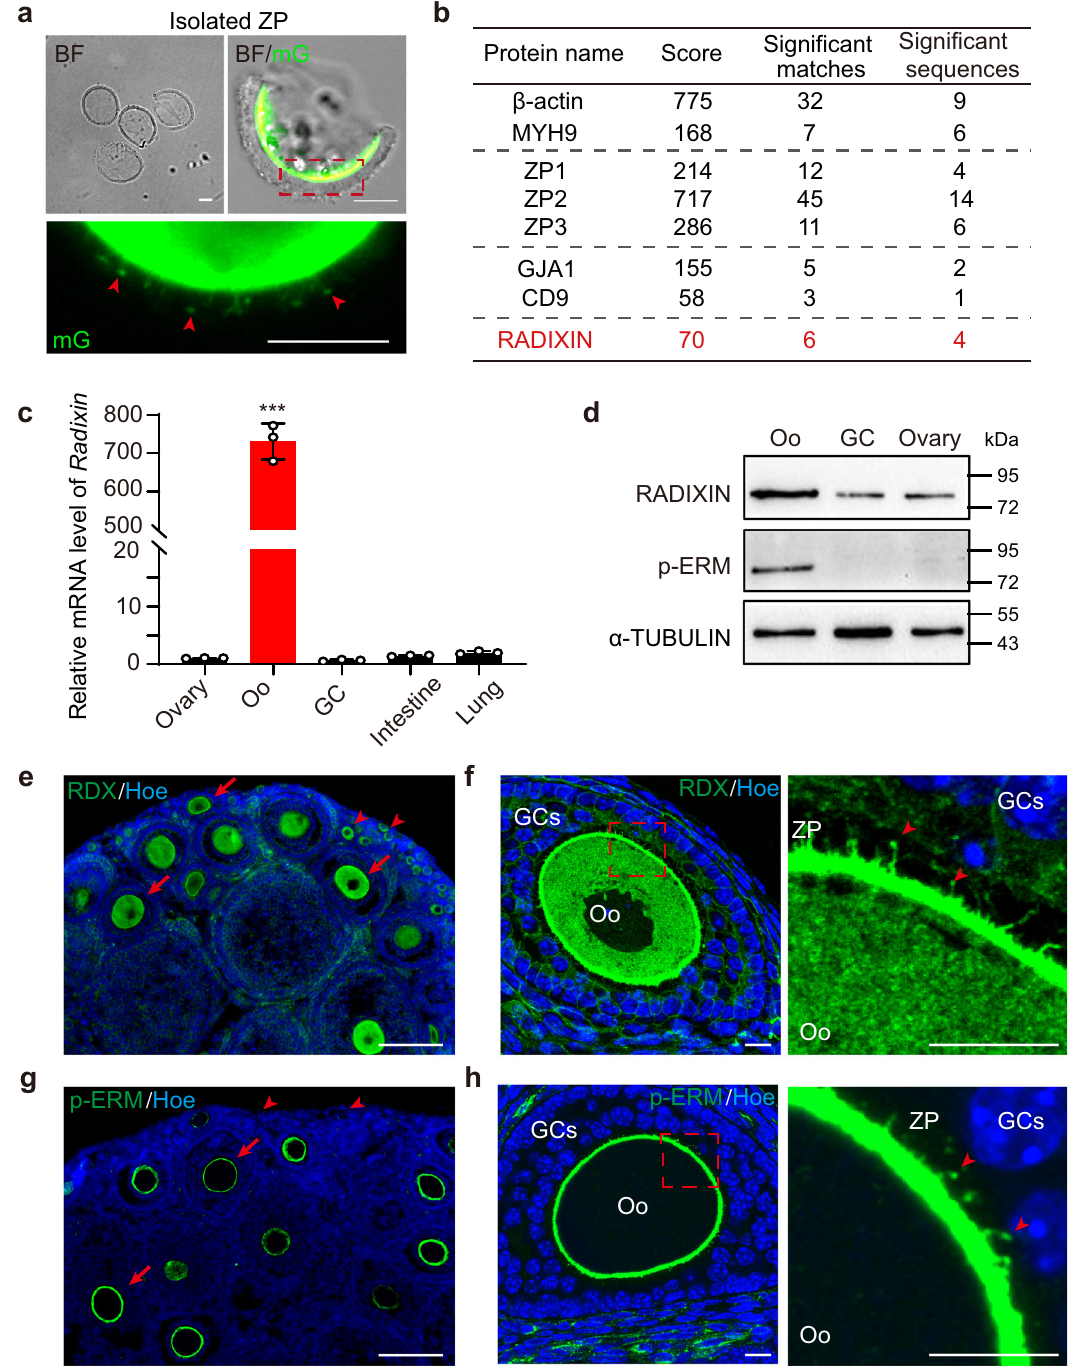
Fig. 2 The microvilli-related protein RDX was speci fi cally expressed in oocytes. a Isolated ZP from Gdf9-Cre;mTmG oocytes with Oo-Mvi (arrowheads) kept in the samples for MS analysis. b MS analysis revealing the expression of RDX in the isolated ZP. c Relative mRNA levels of Rdx in different follicle components and tissues showing high Rdx expression in oocytes. n = 3 and P -value (Ovary vs. Oo) = 0.0014. d Western blot showing that RDX and p-ERM are highly expressed in oocytes. e Immunostaining showing RDX protein localized in the oocytes of follicles from the dormant primordial (arrowheads) to growing (arrow) stages. g p-ERM highly expresses on the membrane of oocytes in growing follicles (arrows) but not on that of dormant oocytes in primordial follicles (arrowheads). f , h High-magni fi cation images showing the localization of RDX ( f ) or p-ERM ( h ) in the Oo-Mvi (arrowheads). All experiments were repeated at least three times, and representative images are shown. Data are presented as the mean ± SD with experiments performed in triplicate. Data were analyzed by two-tailed unpaired Student ’ s t -test and *** P < 0.001. Oo oocyte. GCs granulosa cells. ZP zona pellucida. Scale